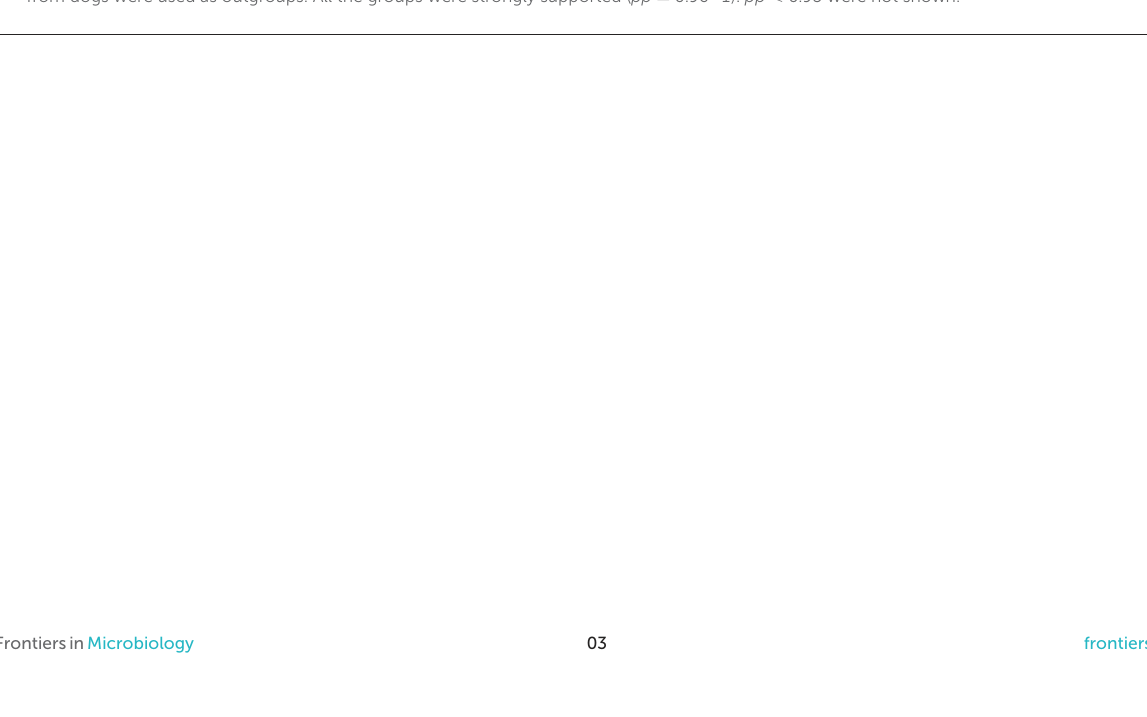
FIGURE2 Relationships among the genotypes of Enterocytozoon bieneusi recorded in the wildlife in this study inferred from the phylogenetic analysis of sequence data for the internal transcribed spacer (ITS) of nuclear ribosomal DNA by Bayesian inference (BI). Statistically significant posterior probabilities (pps) are indicated on branches. Individual GenBank accession numbers precede genotype designation (in italics) followed by sample and locality descriptions. The Enterocytozoon bieneusi genotypes identified and characterized from fecal DNA samples in the present study are indicated in bold type. Clades were assigned group names based on the classification system established by Karim et al. (2015) and Li et al. (2019a). The scale bar represents the number of substitutions per site. The E. bieneusi genotypes PtEbIX (DQ885585) and CD8 (KJ668735) from dogs were used as outgroups. All the groups were strongly supported ( pp = 0.96–1). pp < 0.95 were not